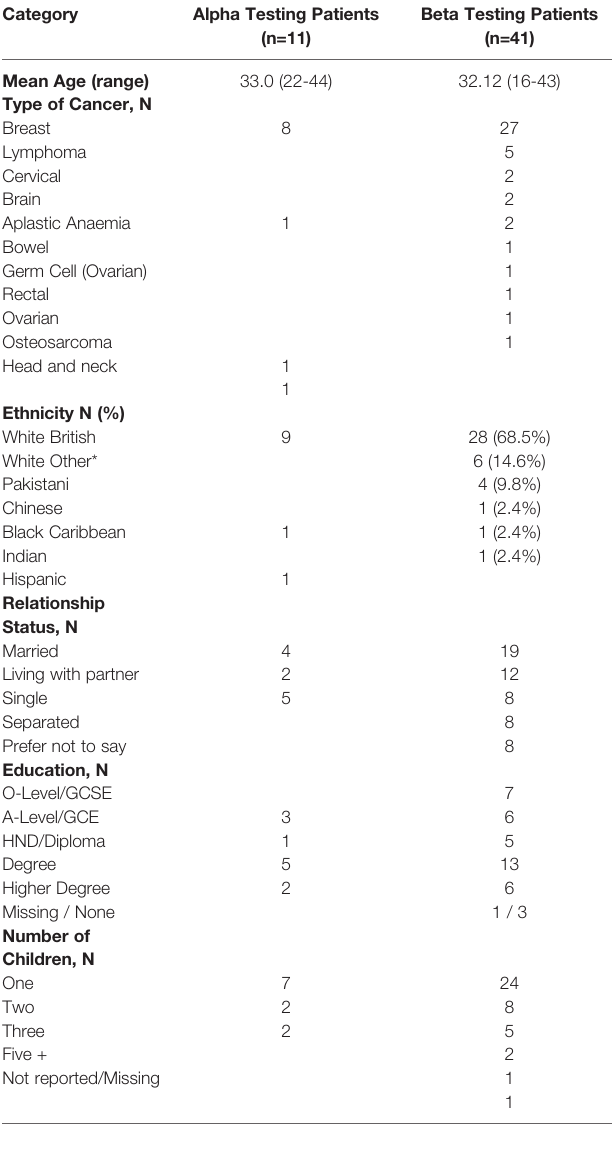
TABLE 2 | Demographic and clinical characteristics of the patient and HCPs in the alpha and beta testing stages of the study.